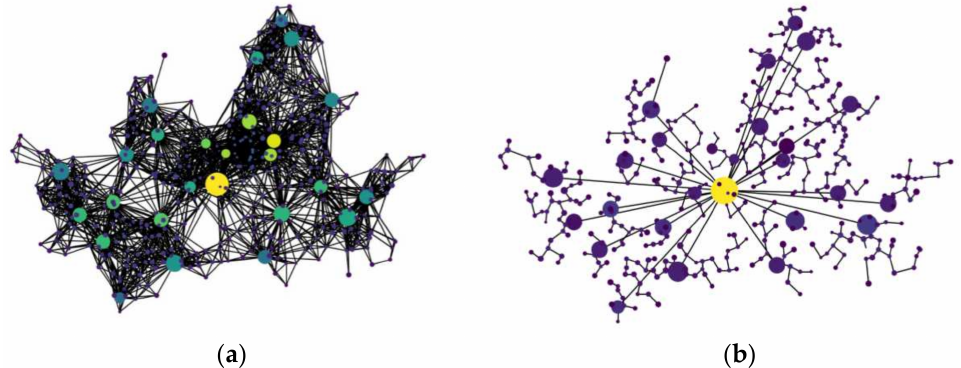
Figure 6. An example fog network for simulations: ( a ) a physical network with FENs in a mesh topology; and ( b ) a logical representation of the physical network of ( a ) in a tree topology [12].